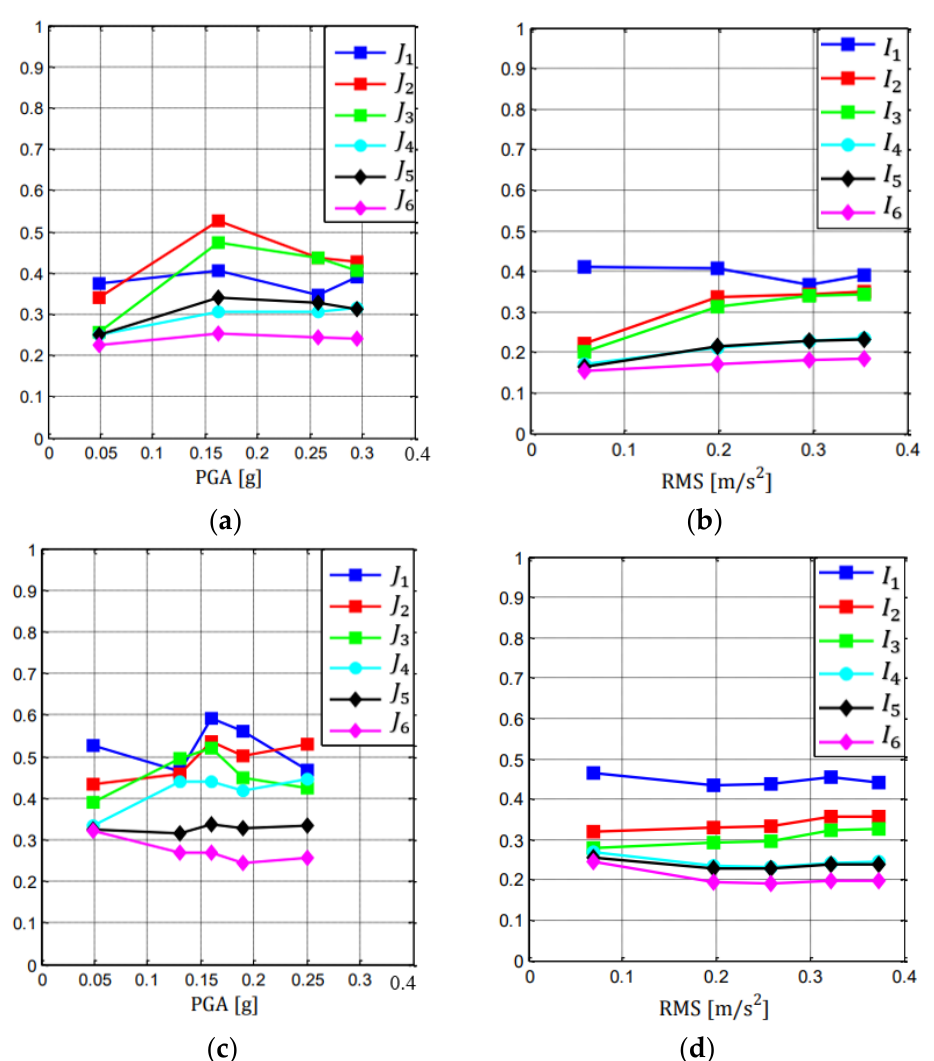
Figure 15. NE — response indices based on maximum values ( 𝐽 𝑛 ) and RMS values ( 𝐼 𝑛 ), n = 1 – 6, varying the input intensity for near-fault earthquakes: ( a , b ) Kobe, ( c , d ) Northridge.